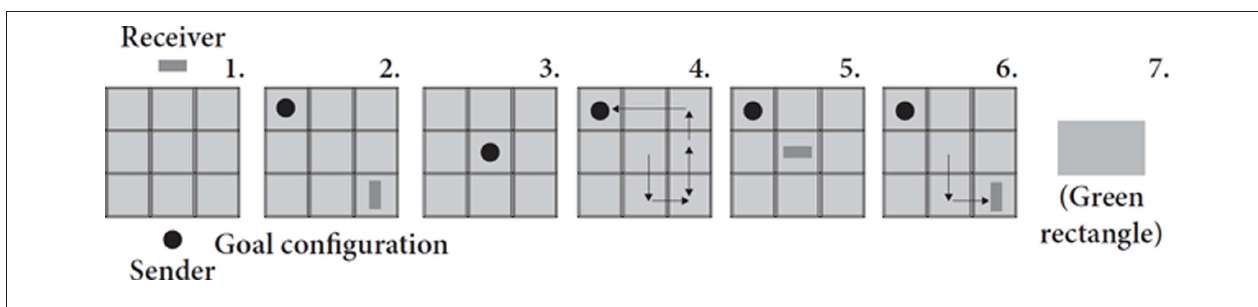
Figure 10 | Sequence of events in the Tacit Communication game developed by de ruiter and colleagues. 1. Players view their shapes (1500